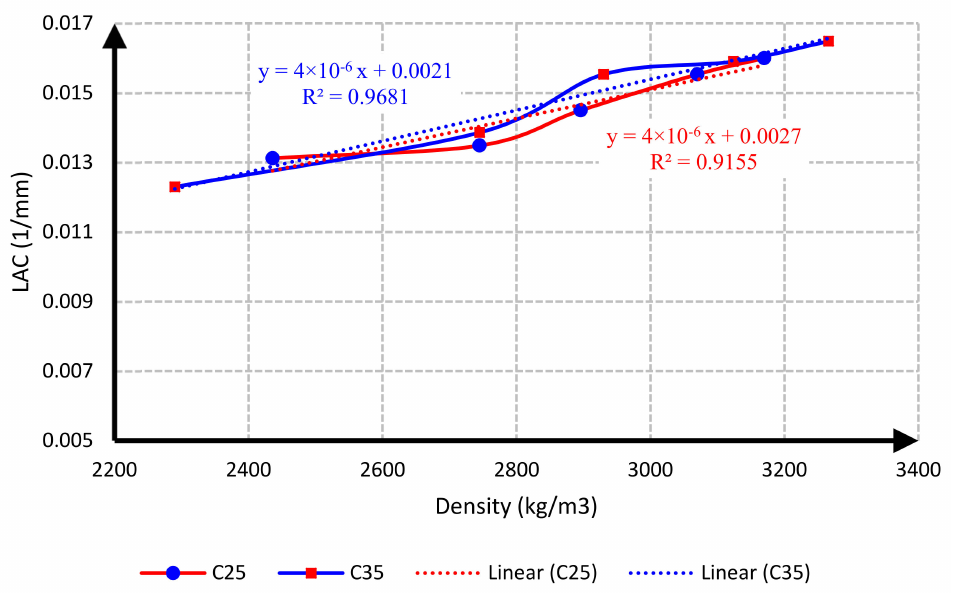
Figure 18. Density–LAC relationship for C25 and C35